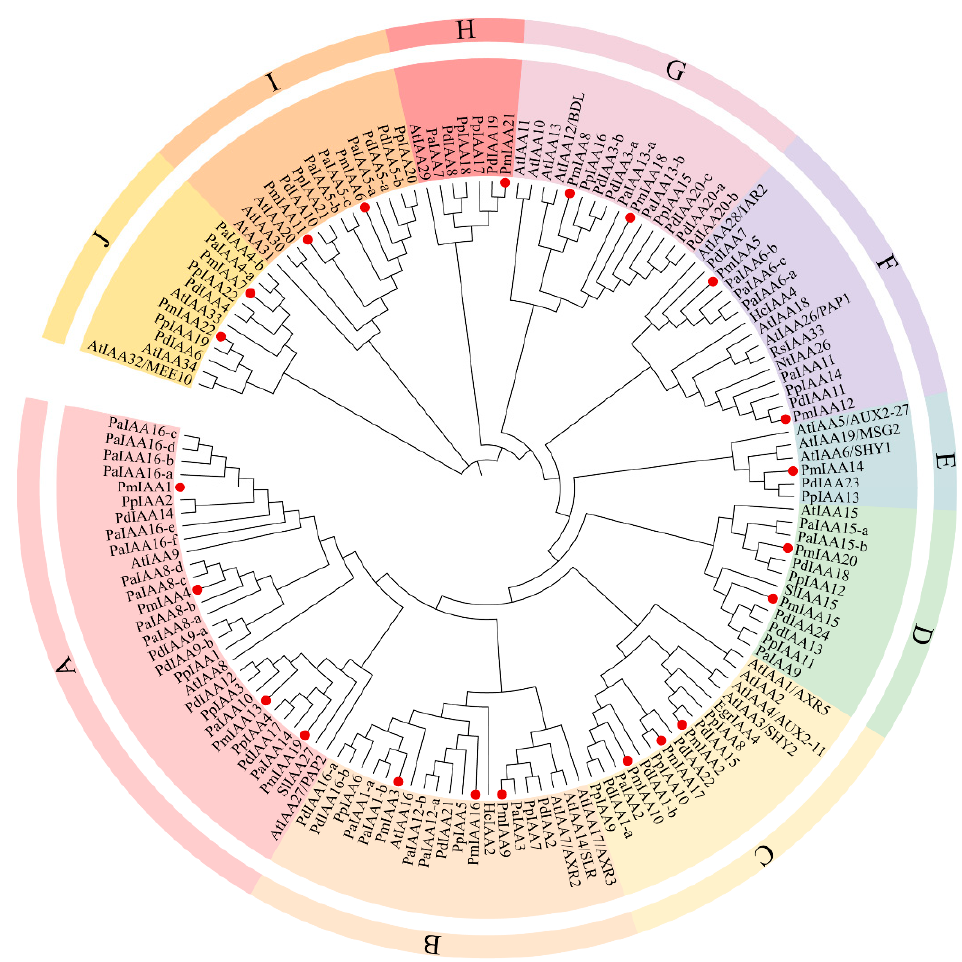
Figure 1. Phylogenetic tree of Aux/IAA family members from P. mume , P. persica , P. dulcis , P. armeniaca , A. thaliana , and other species. The tree was constructed on the basis of sequence alignment of amino acid sequences using neighbor-joining method with 1000 bootstrap replications. Different colors indicate ten different subgroups, and red dots highlight PmIAAs. All referred Aux/IAA genes are listed in Table